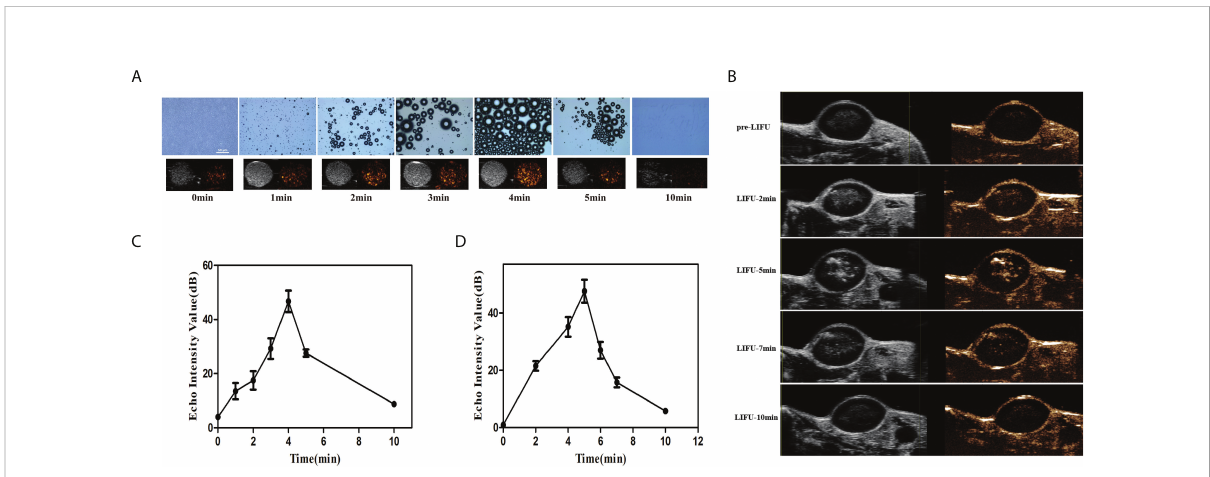
FIGURE 5 In vitro and in vivo PFH phase transition. (A) In vitro optical microscopy images of PFH/ART@PLGA/Fe 3 O 4 -eFA at different time points (pre- irradiation and 1, 2, 3, 4, 5 and 10 min post-LIFU irradiation, from left to right) and ultrasound (US) images captured in contrast-enhanced ultrasound (CEUS) and B-mode (bottom row) of the gas microbubbles generated by the corresponding PFH/ART@PLGA/Fe 3 O 4 -eFA at the same time points. (B) In vivo echo signal intensity of US images captured in CEUS mode of tumors at different time points (pre-irradiation and 2, 5, 7 and 10 min post irradiation) at 12 h after PFH/ART@PLGA/Fe 3 O 4 -eFA NP injection. (C) Quantitative analysis of the echo signal intensity of the US images captured in CEUS mode of NPs in vitro . (D) Quantitative analysis of the echo signal intensity of US images captured in CEUS mode of tumors in vivo . All the error bars represent standard deviation (n =